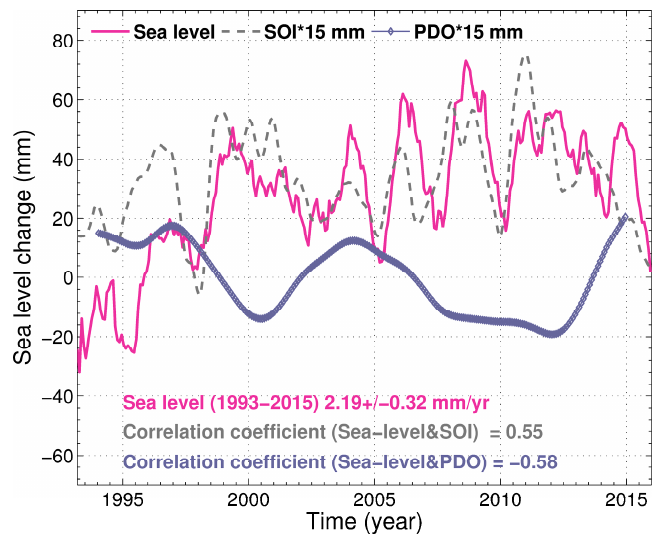
Figure 5. Sea-level changes around Taiwan derived from the satellite altimetric data covering the time span from 1993 to 2015. The seasonal signals have been removed, and an 11-month smoothing applied to the altimetric data. The gray dashes and purple diamond curves denote the low-pass southern oscillation index (SOI) and Pacific decadal oscillation (PDO), respectively, using 11-month and five-year smoothing, respectively. The correlation coefficients were calculated by the Pearson method, and the p -value is <0.05.